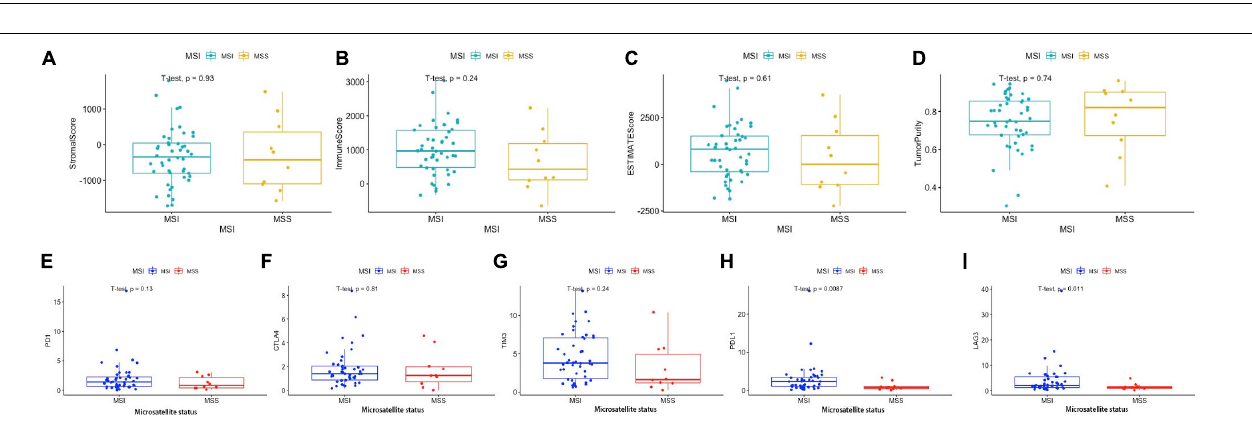
FIGURE 11 | Expression of immune cells in colon cancer. Staining of CD4 (A,B) , CD8 (C,D) , Syndecan-1 (E,F) , HLA-DR (G,H) , and myeloperoxidase (I,J) in BRAF wild-type (A,C,E,G,I) and BRAF mutated (B,D,F,H,J) samples at magnification × 200. * p < 0.05, ** p < 0.01, *** p < 0.001.